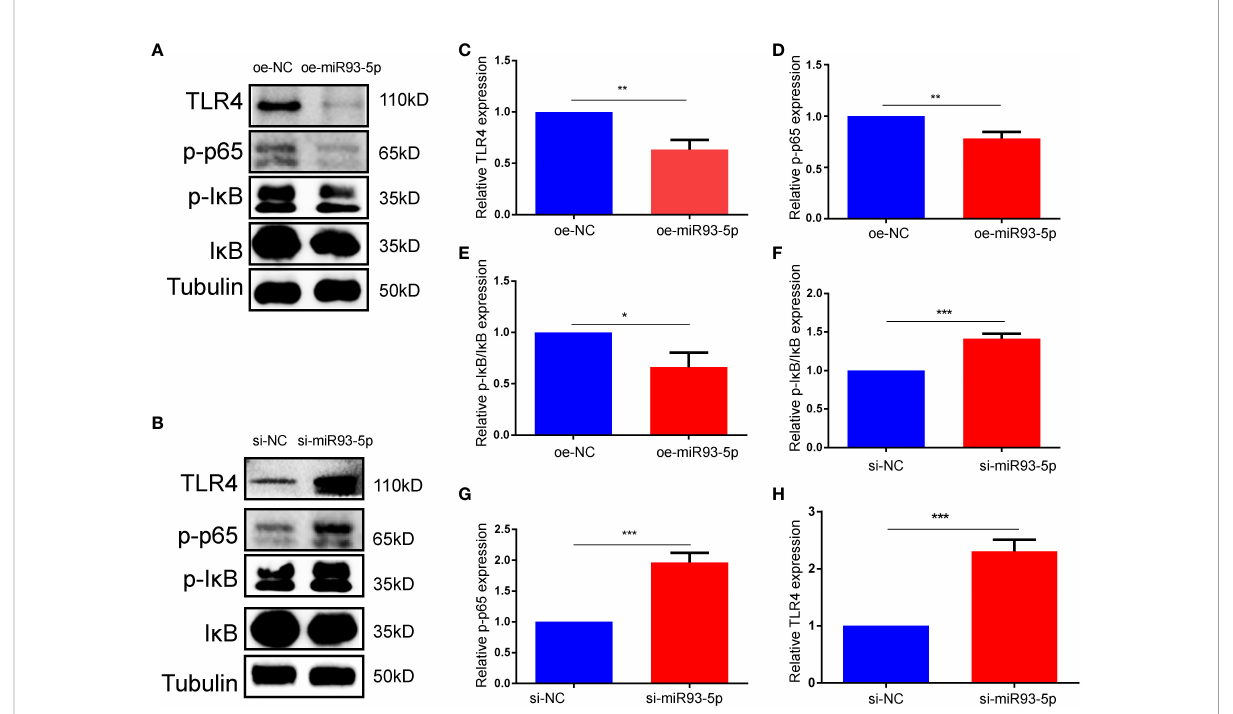
FIGURE 7 miR-93-5p negatively regulates the NF- k B signaling pathway. (A, B) WB results showed that the protein expression of TLR4, p-p65 and p-I k B/ I k B was decreased in the oe-miR93-5p group compared with the oe-NC group, while was increased in the si-miR93-5p group compared with the si-NC. The bar charts are used to visualize the expression of (C, F) TLR4, (D, G) p-p65, (E, H) p-I k B/I k B. p < 0.05 ( “ * ” ), p < 0.01 ( “ ** ” ), p < 0.001 ( “ *** ”